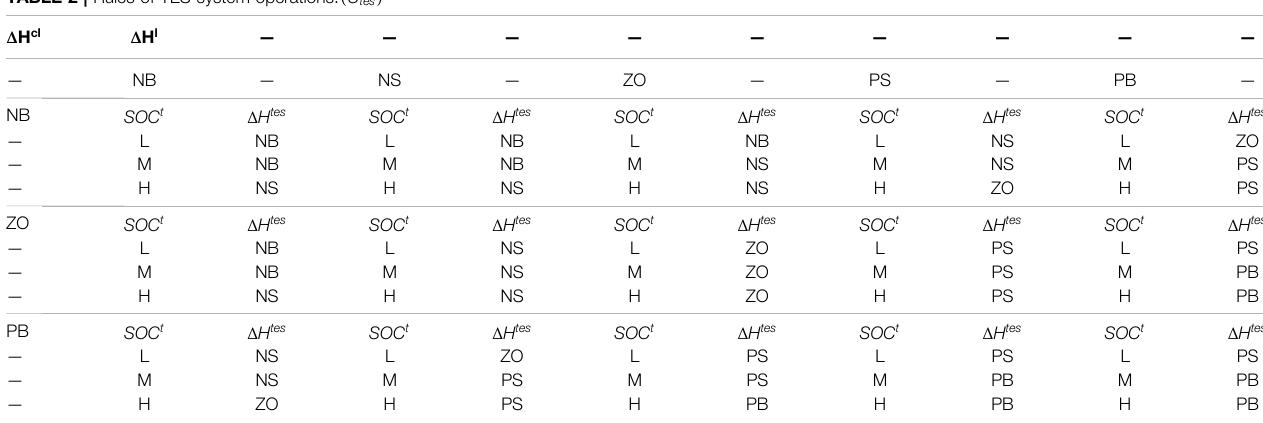
TABLE 2 | Rules of TES system operations. ( U tes